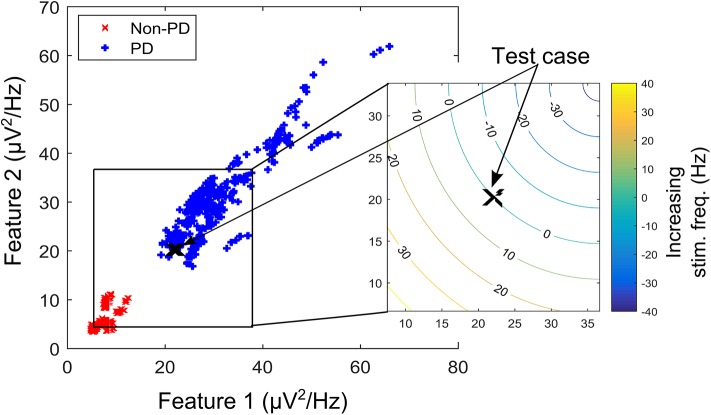
A contour plot depicting the effect of increasing/decreasing stimulation frequency on the transition path of a test case (in the XY-location marked “X”) over the feature space. Feature space is that of dataset B.